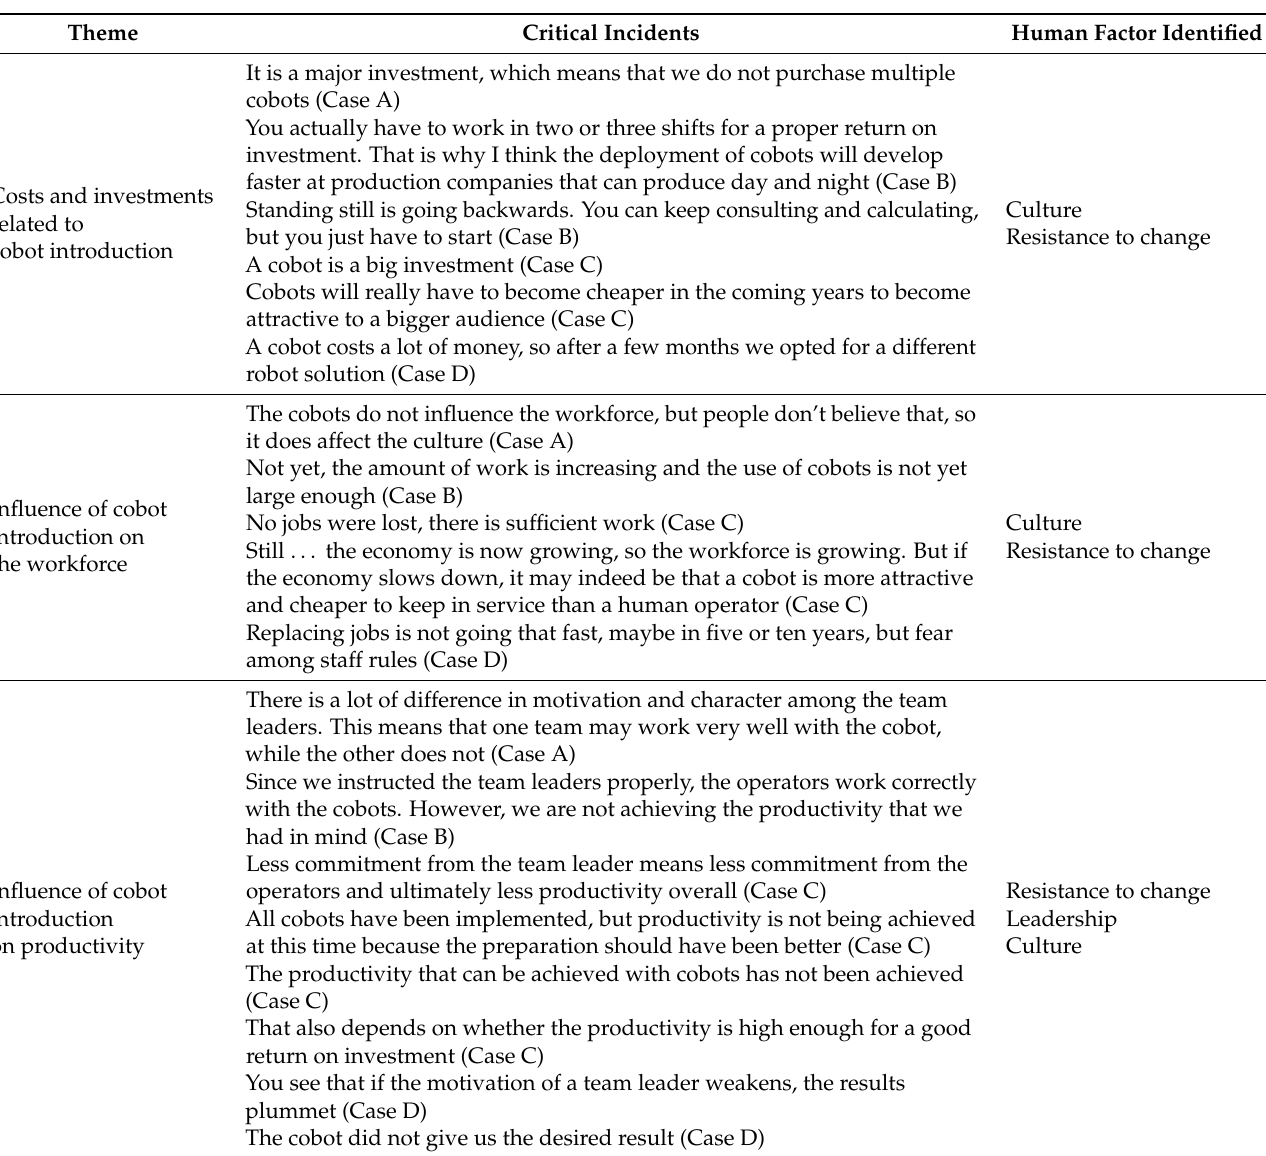
Table 3. Critical incidents and human factors identified related to investments, workforce, and productivity during the implementation